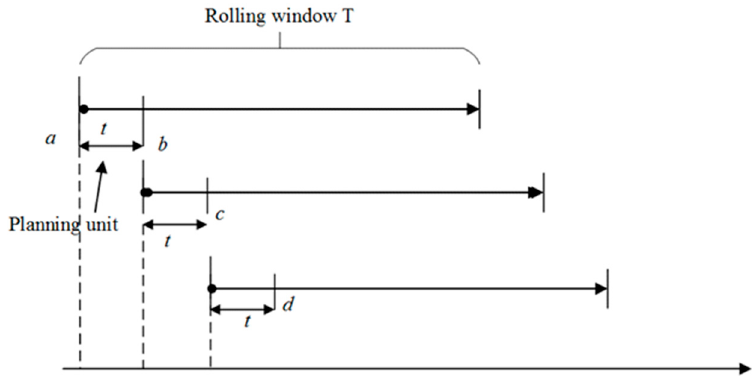
Figure 2. The rolling process.